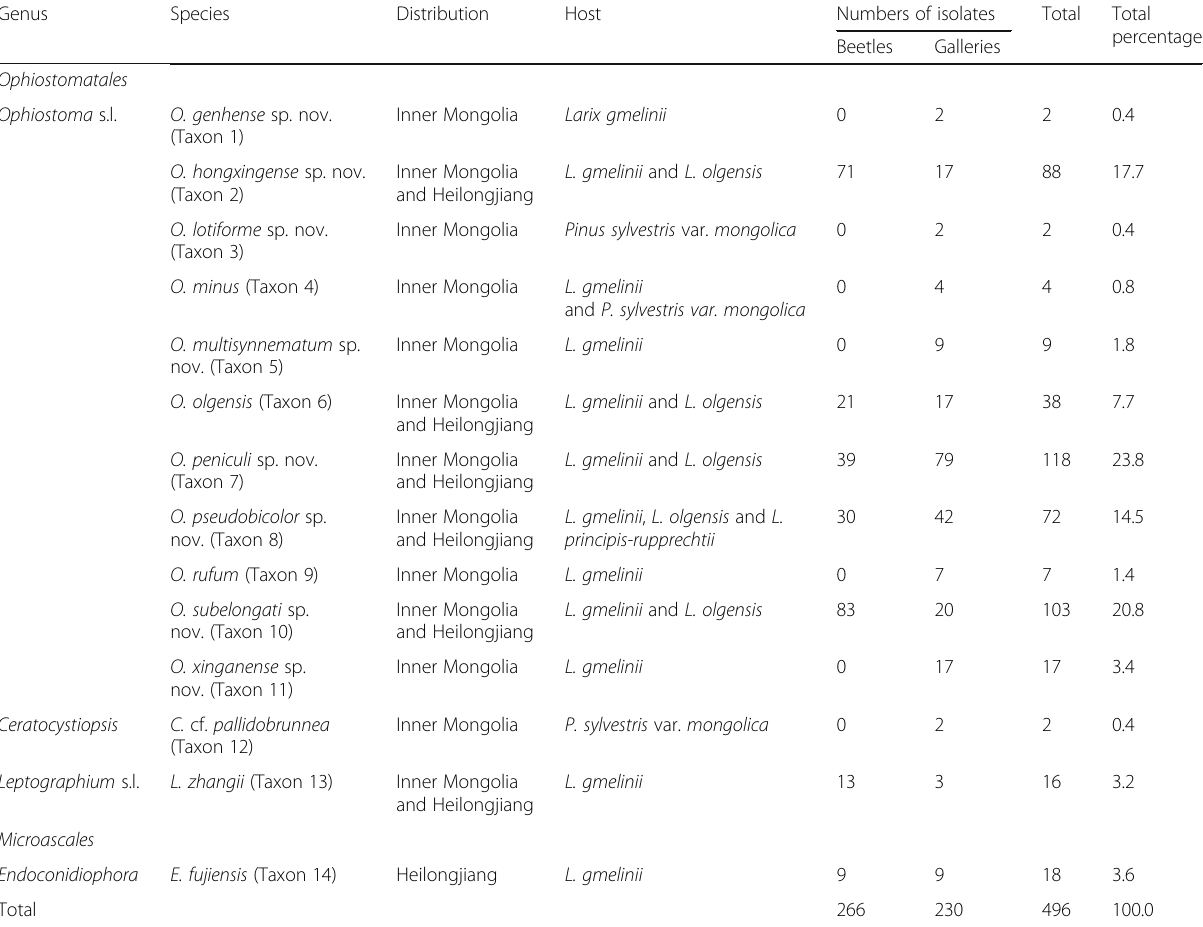
Table 2 Strains of ophiostomatoid fungi associated with Ips subelongatus in northeast China